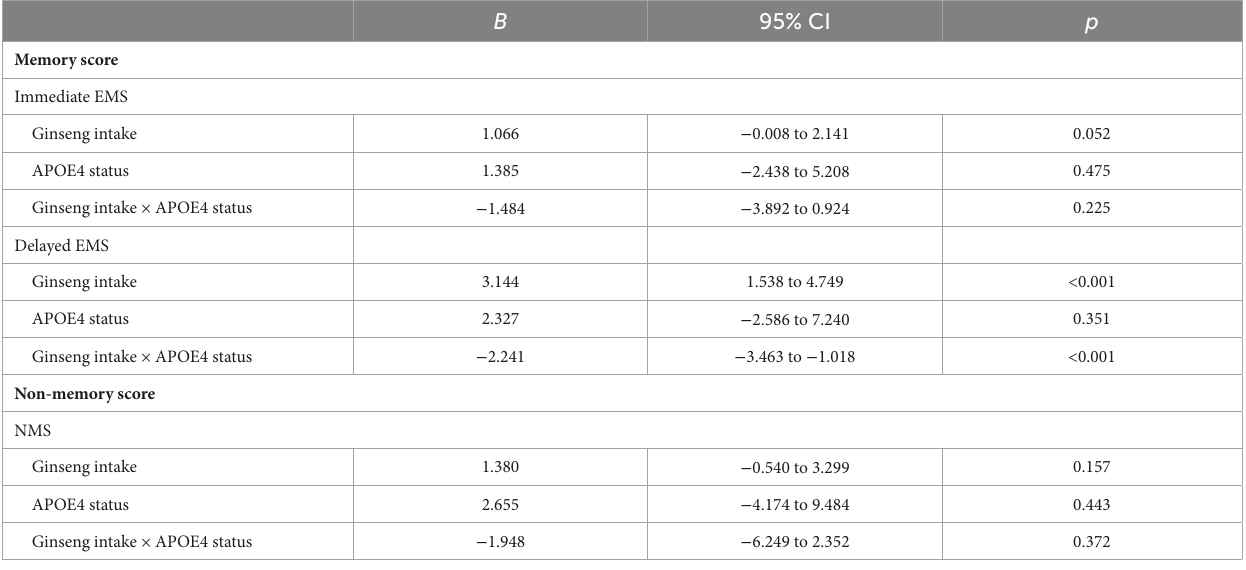
TABLE 3 Results of multiple linear regression analyses that included interaction terms for the association between ginseng intake status and APOE4 status in predicting cognition.